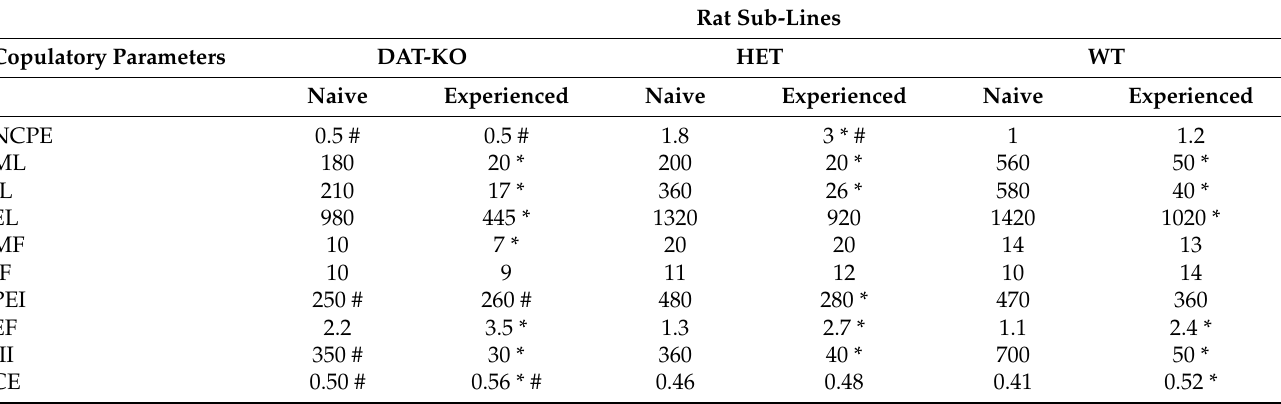
Table 15. Mean values of copulatory parameters of the first series of copulatory activity of male DAT-KO, HET and WT rat sub-lines at the first (sexually naïve condition) and at the fifth copulatory test (sexually experienced condition) with a receptive female rat.